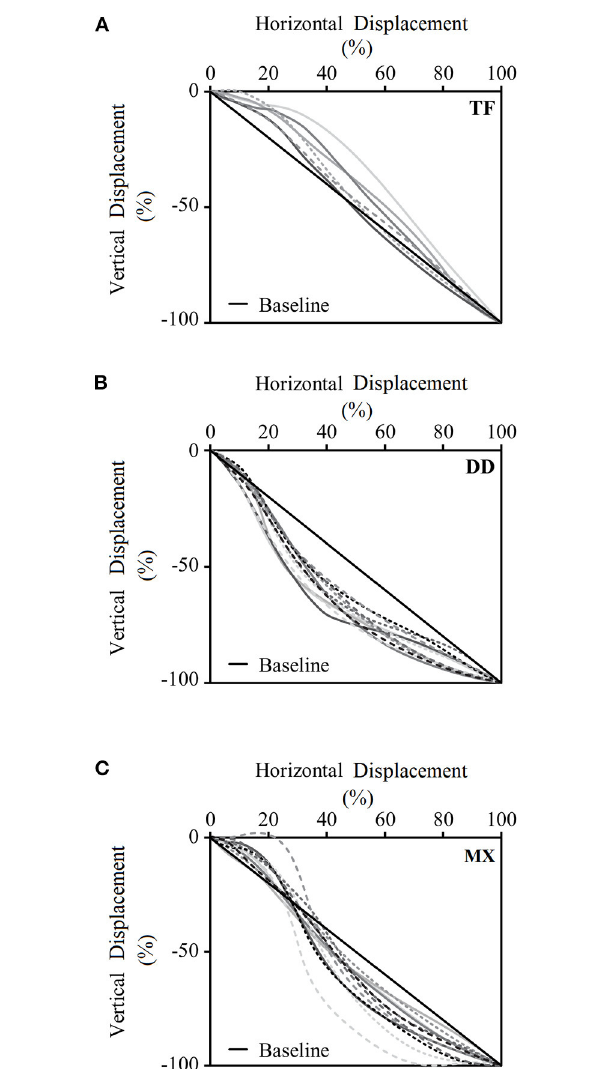
FIGURE 2 | Pelvis center trajectories in the stride phase. The horizontal axis of the figure represents the standardized pelvis center movement in the X-axis (forward-pitching direction) during the stride phase. The vertical axis of the figure represents the standardized pelvis center movement in the Z-axis (vertical direction) during the stride phase. Graphs illustrate the pelvis center trajectories of (A) tall-and-fall pitchers, (B) dip-and-drive pitchers, and (C) mixed pitchers. TF, tall-and-fall pitchers; DD, dip-and-drive pitchers; MX, mixed